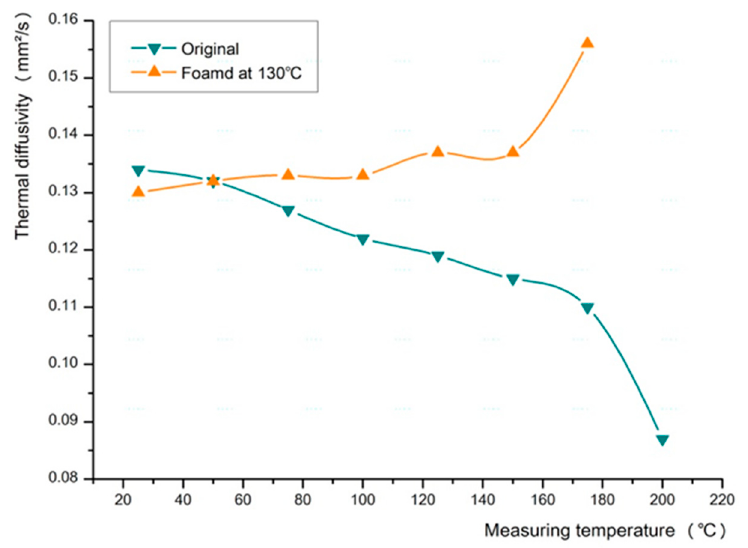
Figure 8. Changes in the thermal diffusivity of ceramic urethane.